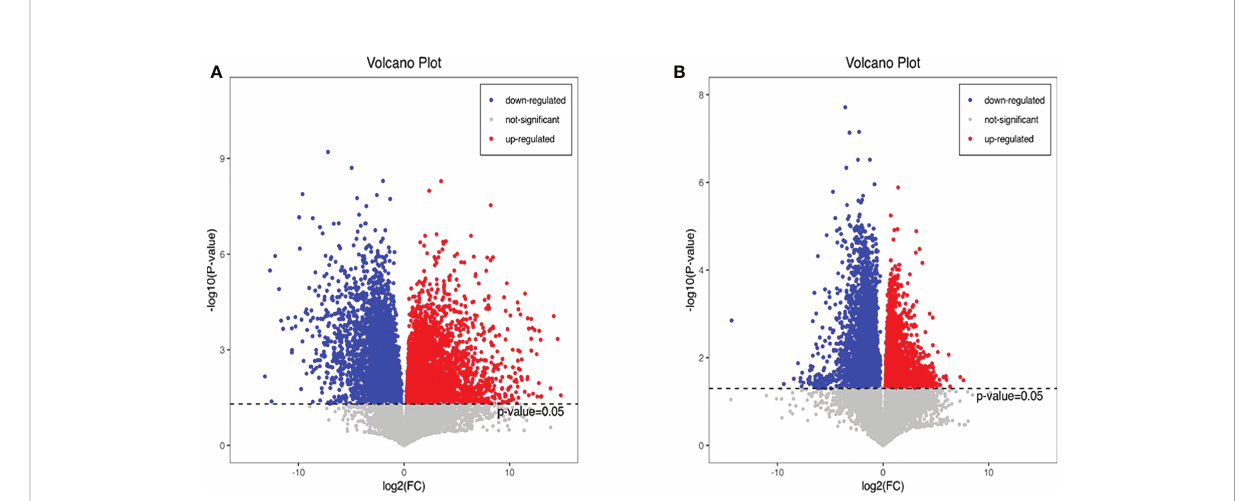
FIGURE 7 Differential metabolites with FC greater than 1 and P-value less than 0.05 were shown. The volcano plots (A, B) of differential metabolites in the mice of NCD vs HFD and HFD vs HFD+Sema groups; FC, fold change; NCD, normal diet; HFD, high-fat diet; Sema,